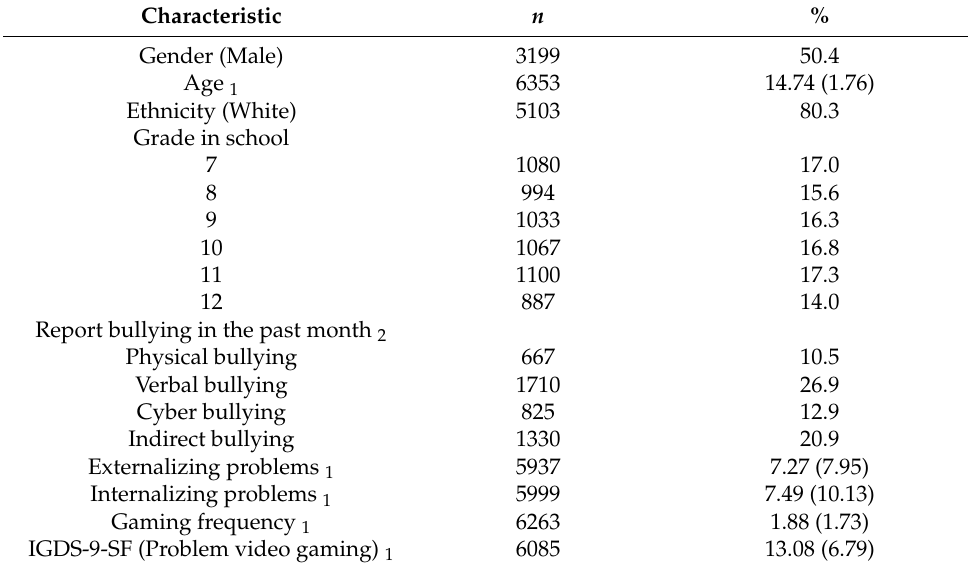
Table 1. Participant characteristics.